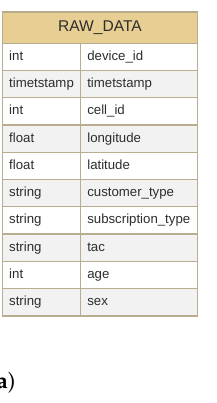
Figure 7. The schema of obtained, “raw” data ( a ), and the normalized data tables ( b